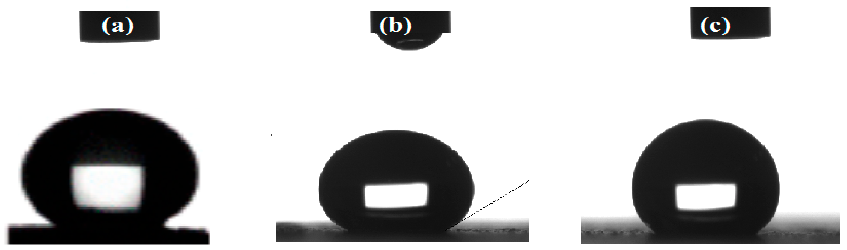
Figure 9. Contact angles of water on HSNP-2 surfaces (HSNP-2 samples were prepared with different contents of ASAS a ) 40, b ) 10, and c ) 5 wt.% at 25 °C).